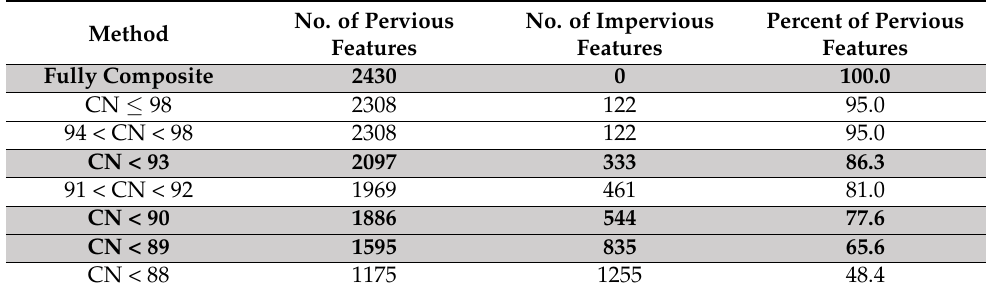
Table 2. Threshold values selection criteria of CN Cut-off approach (Bold values in shading lines correspond to the conditions adopted in the SWMM